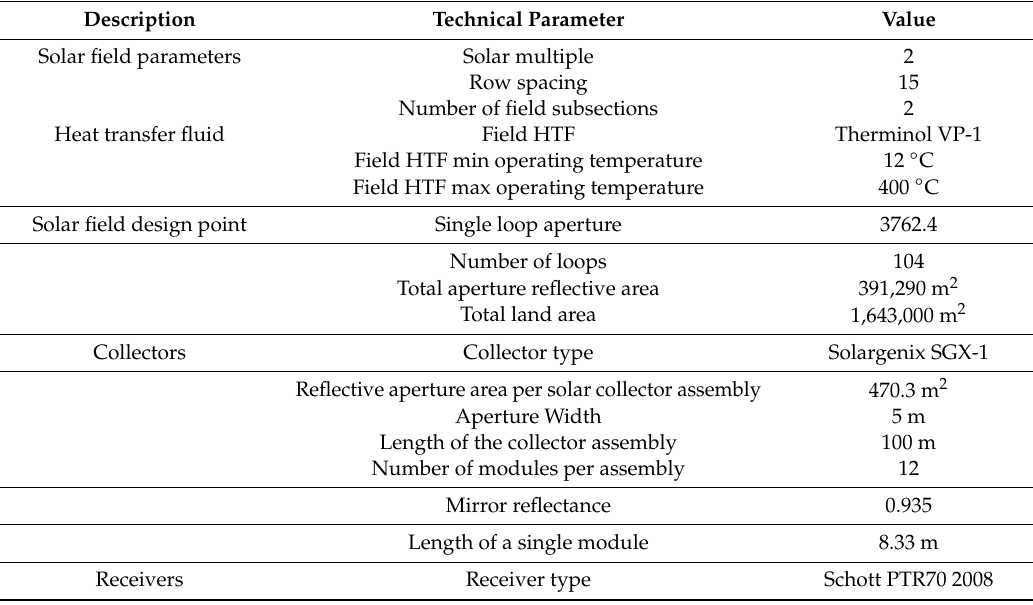
Table 4. Design characteristics and specifications of the 50 MWe PT